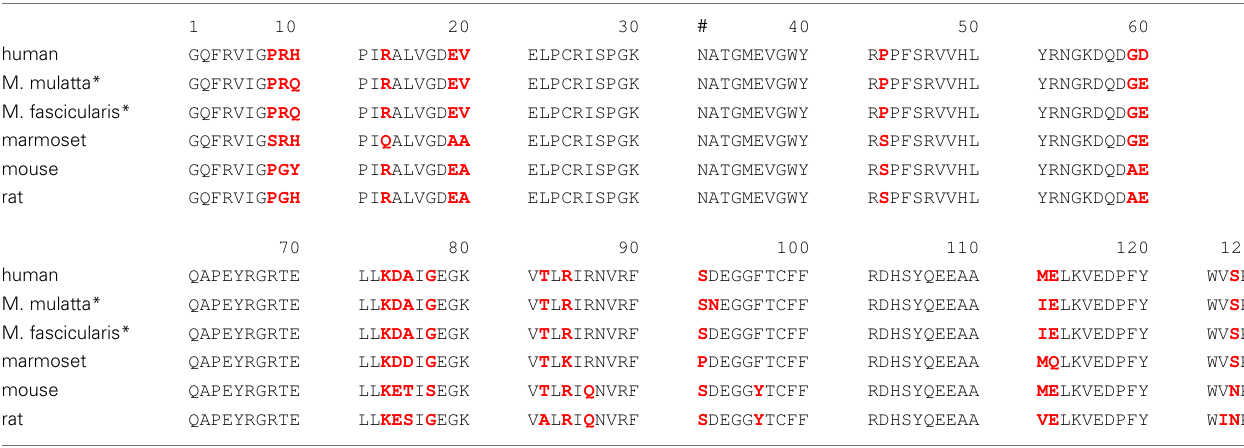
Table 2 |Alignment of amino acids sequences of the myelin oligodendrocyte glycoprotein extracellular domain